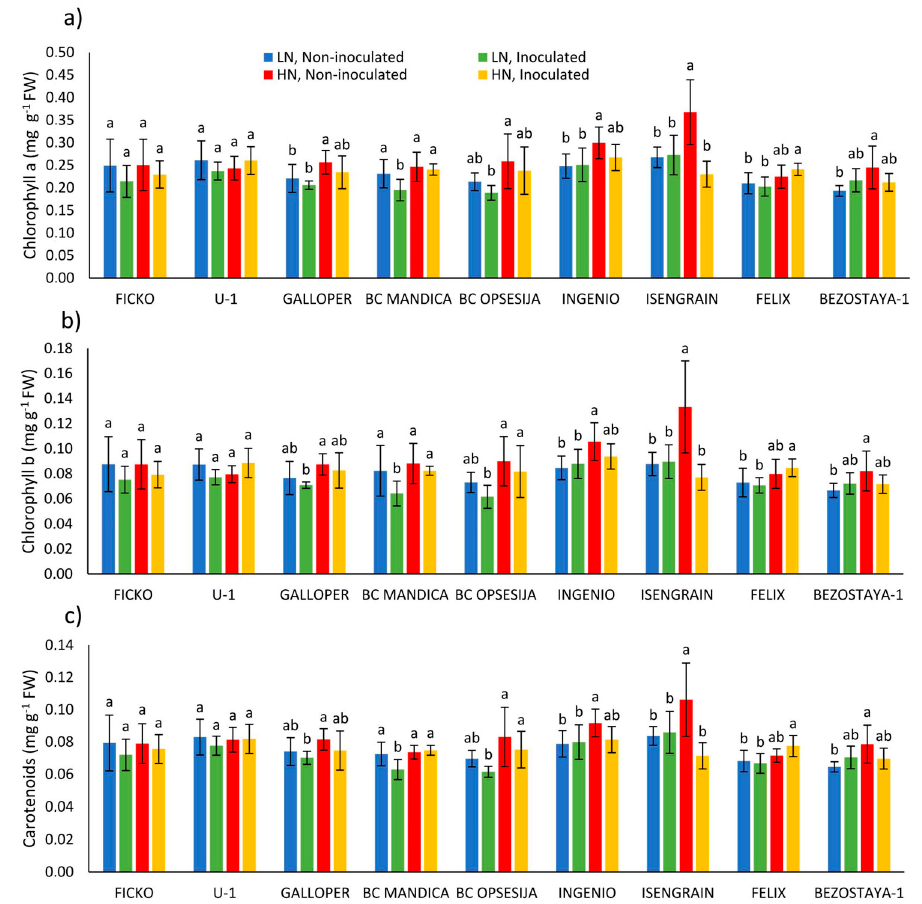
Figure 3. Chlorophyll a ( a ), chlorophyll b ( b ), and carotenoids ( c ) content in spikes of nine wheat varieties under different nitrogen (LN—low nitrogen; HN—high nitrogen) and Fusarium (non- inoculated and inoculated) treatments. Values are means of six replicates ± standard deviation (SD). Different letters above the bars indicate significant differences according to Fisher’s LSD test ( p ≤ 0.05) among different treatment in each variety